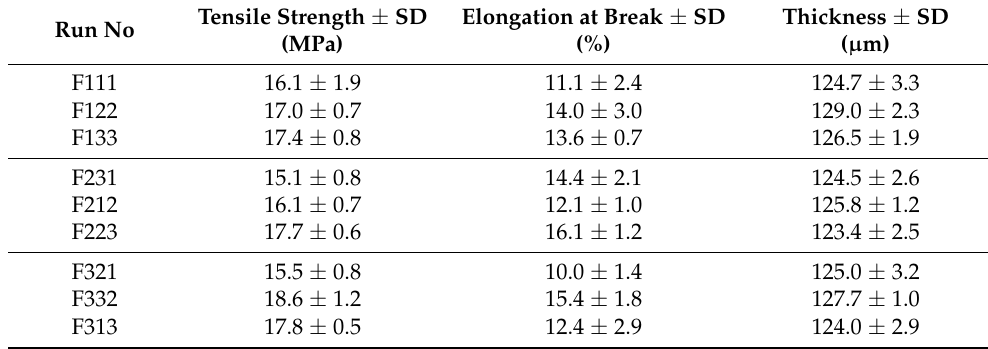
Table 5. Mechanical properties of 23 wt% FNB loaded films with fixed film thickness (0.12–0.13